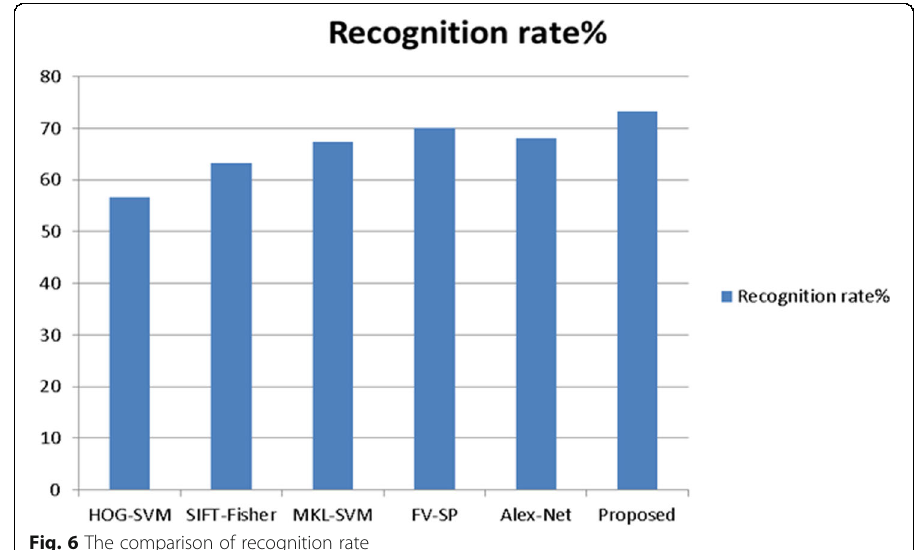
Fig. 6 The comparison of recognition